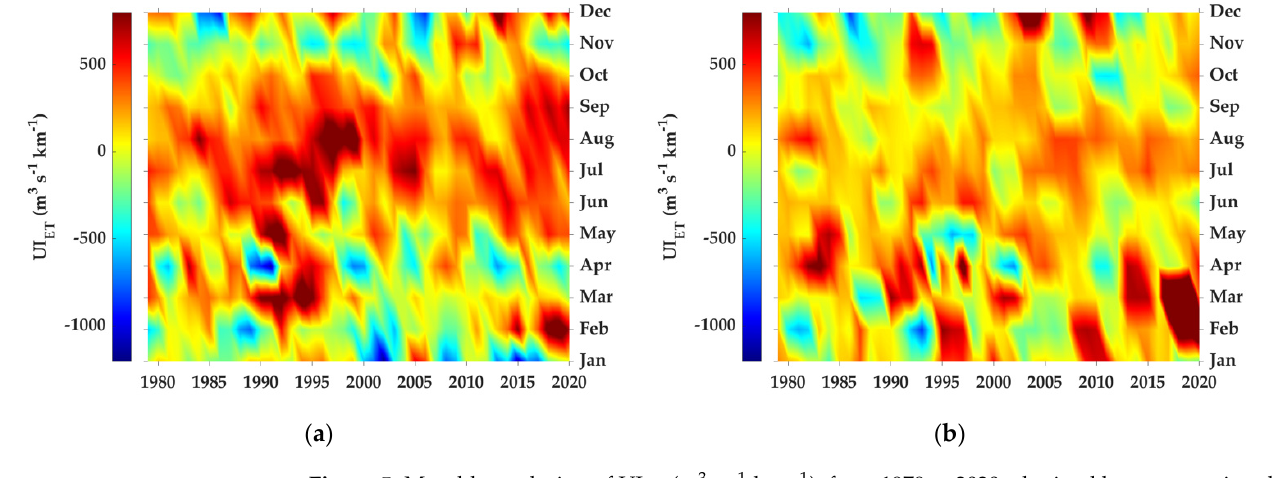
Figure 5. Monthly evolution of UI ET (m 3 s − 1 km − 1 ), from 1979 to 2020, obtained by representing the spatial average of each month in function of the years: ( a ) west coast and ( b ) south coast.